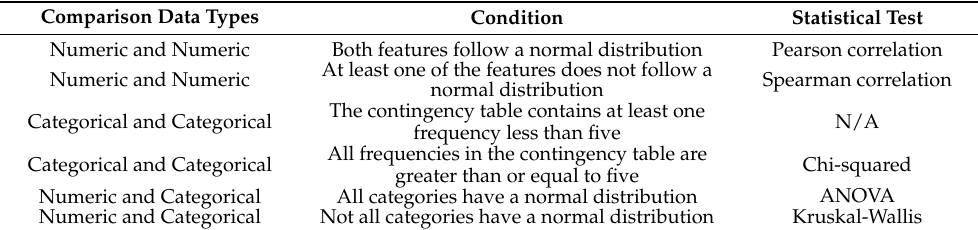
Table 1. Statistical tests chosen for comparisons and their